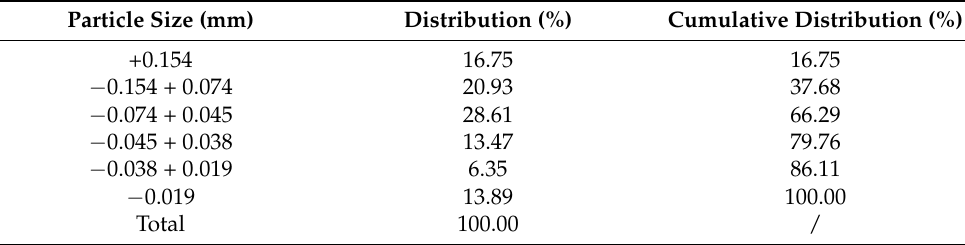
Table 3. Particle size distribution of gold tailings